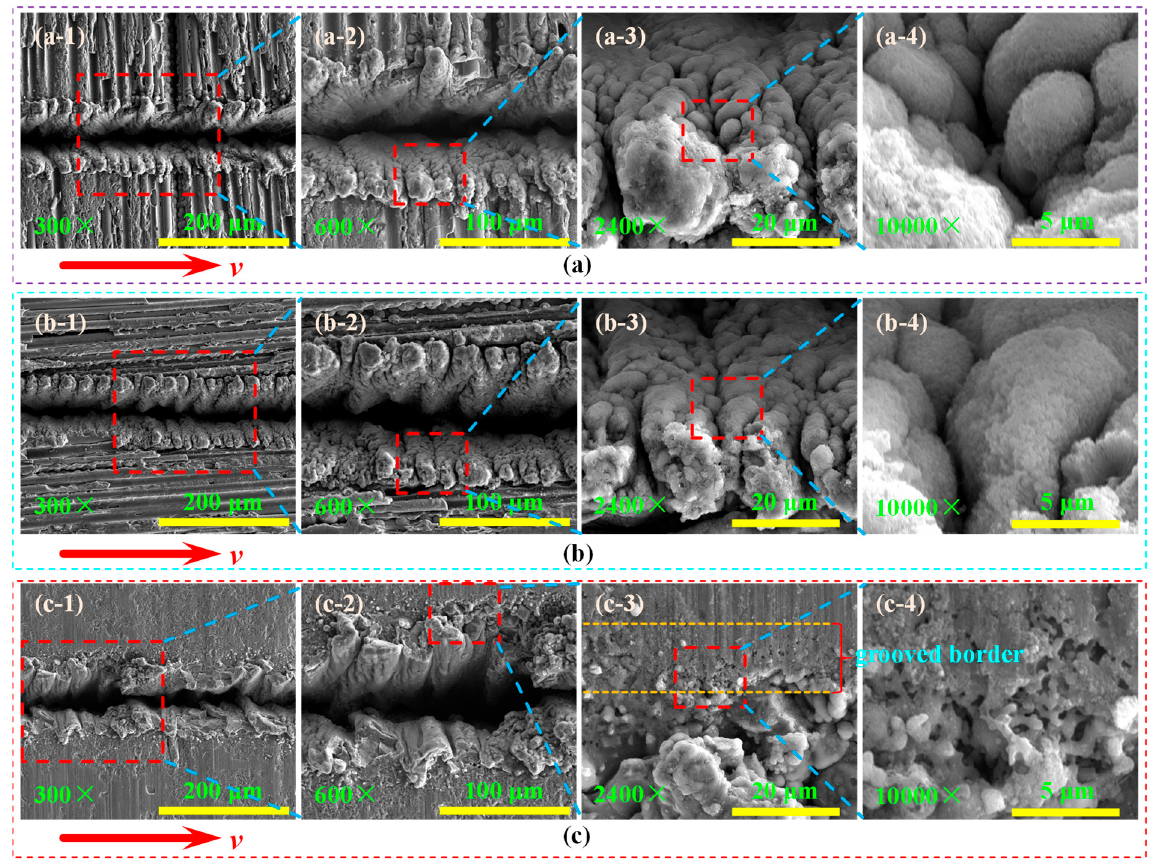
Figure 11. The grooved morphologies in different regions during transverse grooving. ( a-1 – a-4 ) Fiber longitudinal arrangement; ( b-1 – b-4 ) fiber transverse arrangement; ( c-1 – c-4 ) matrix distribution.